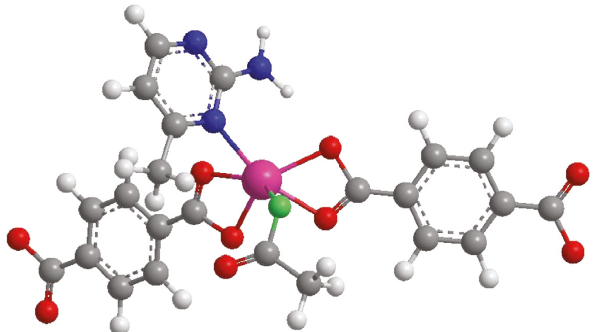
Figure 7: Coordination geometry (Nd) atom. Pink: Nd, red: O, blue: N, and green: OAc.